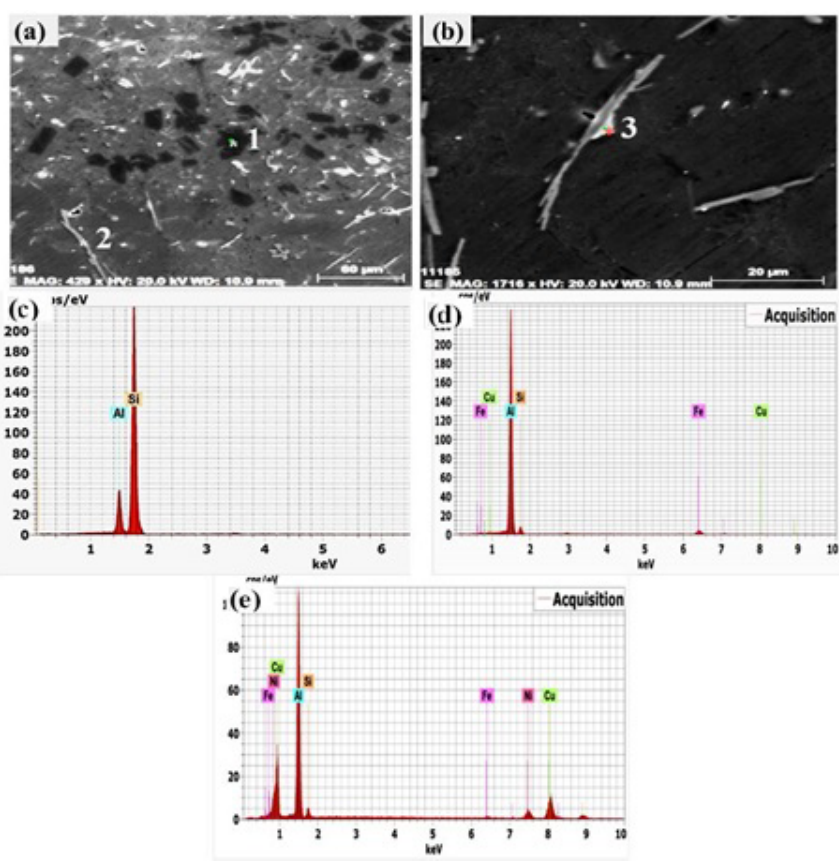
Figure 6. Microstructural analysis and EDS microanalysis data of bimetal casting with a 10s time interval. (a, b) SEM micrographs. (c, e) EDS microanalysis data of points 1 and 3 in the hyper-eutectic region and (d) EDS microanalysis data of point 2 in the hypo-eutectic